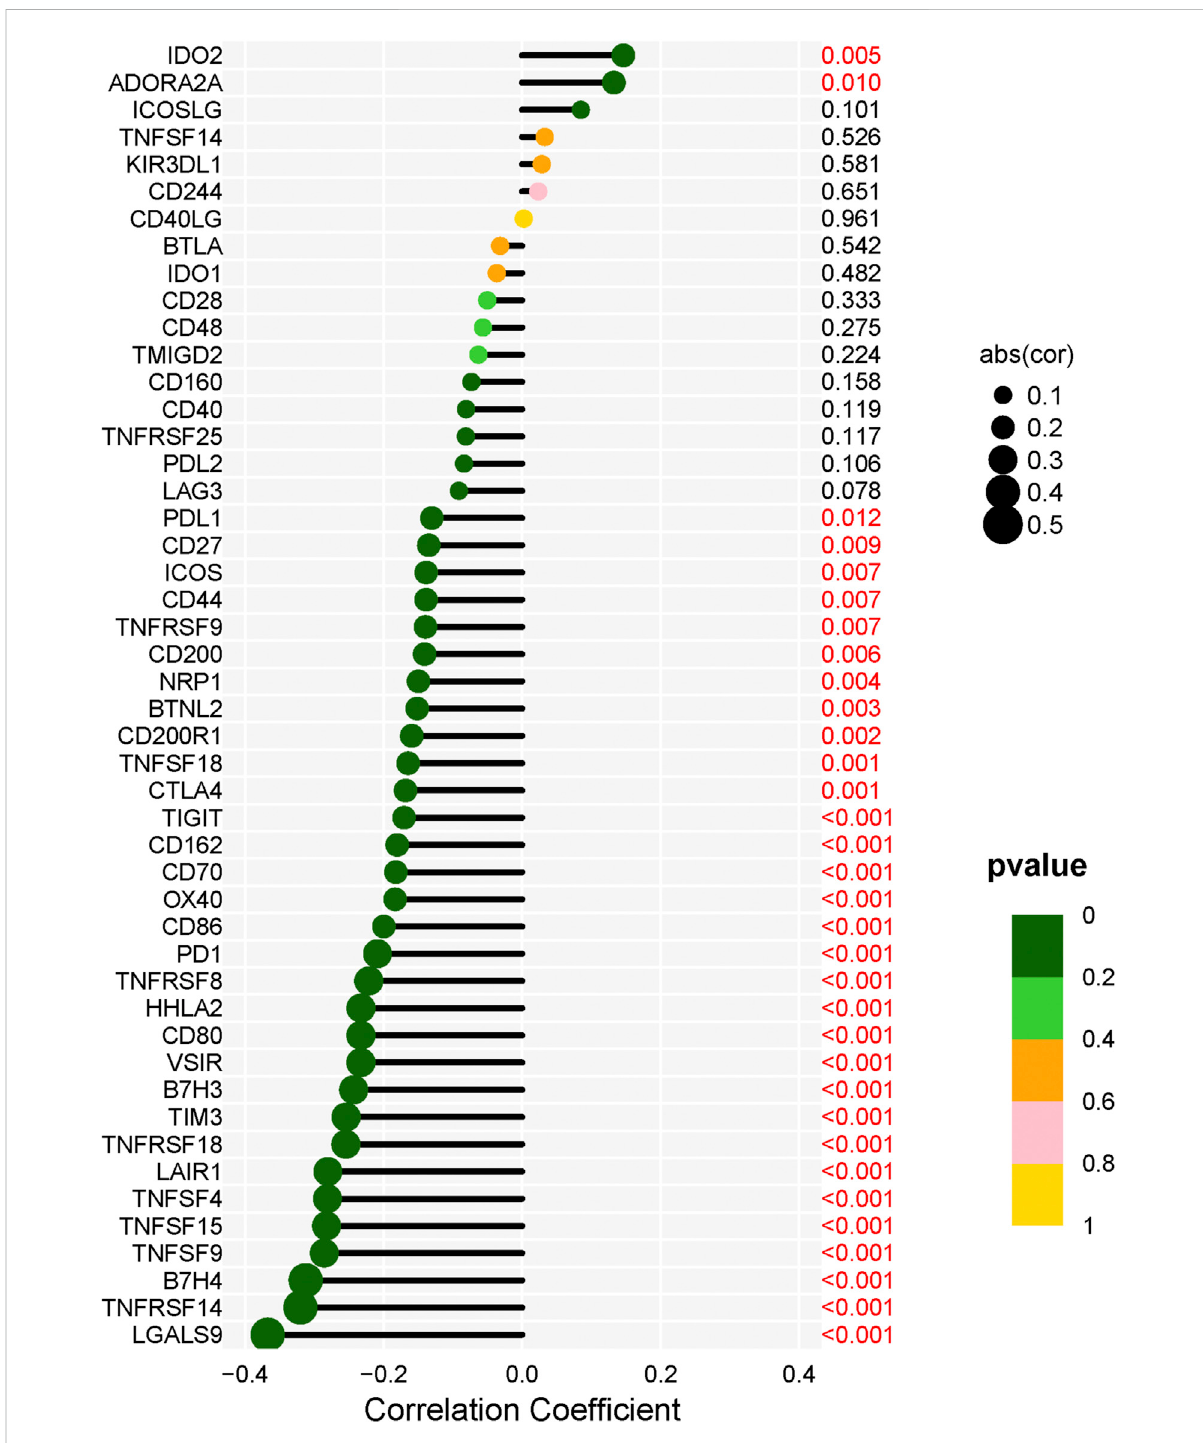
FIGURE 8 Correlation analysis of LECT2 expression with 48 immune checkpoint